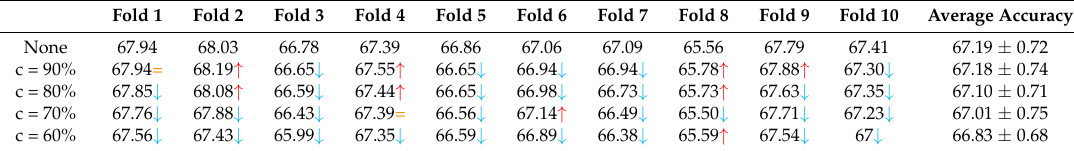
Table 1. Accuracy [%] of different selection ratios on 10 training folds. The rows labeled as “None” are the accuracy of the unselected feature. When a different selection ratio is compared with the baselines, a ↑ or ↓ sign indicates that the results of this selection ratio is better than or worse than the baseline; a = sign indicates that the results of this selection ratio is equal to the baseline. c means the selection ratio.